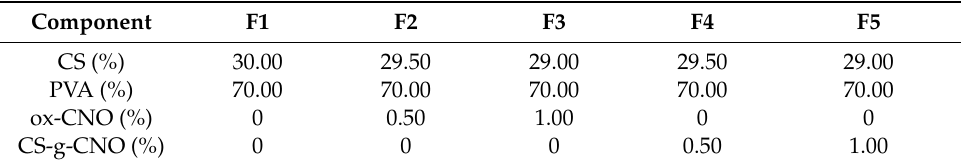
Table 2. Formulations used for the preparation of chitosan (CS) / poly (vinyl alcohol) (PVA) / CS-g-CNO or ox-CNO nanocomposite